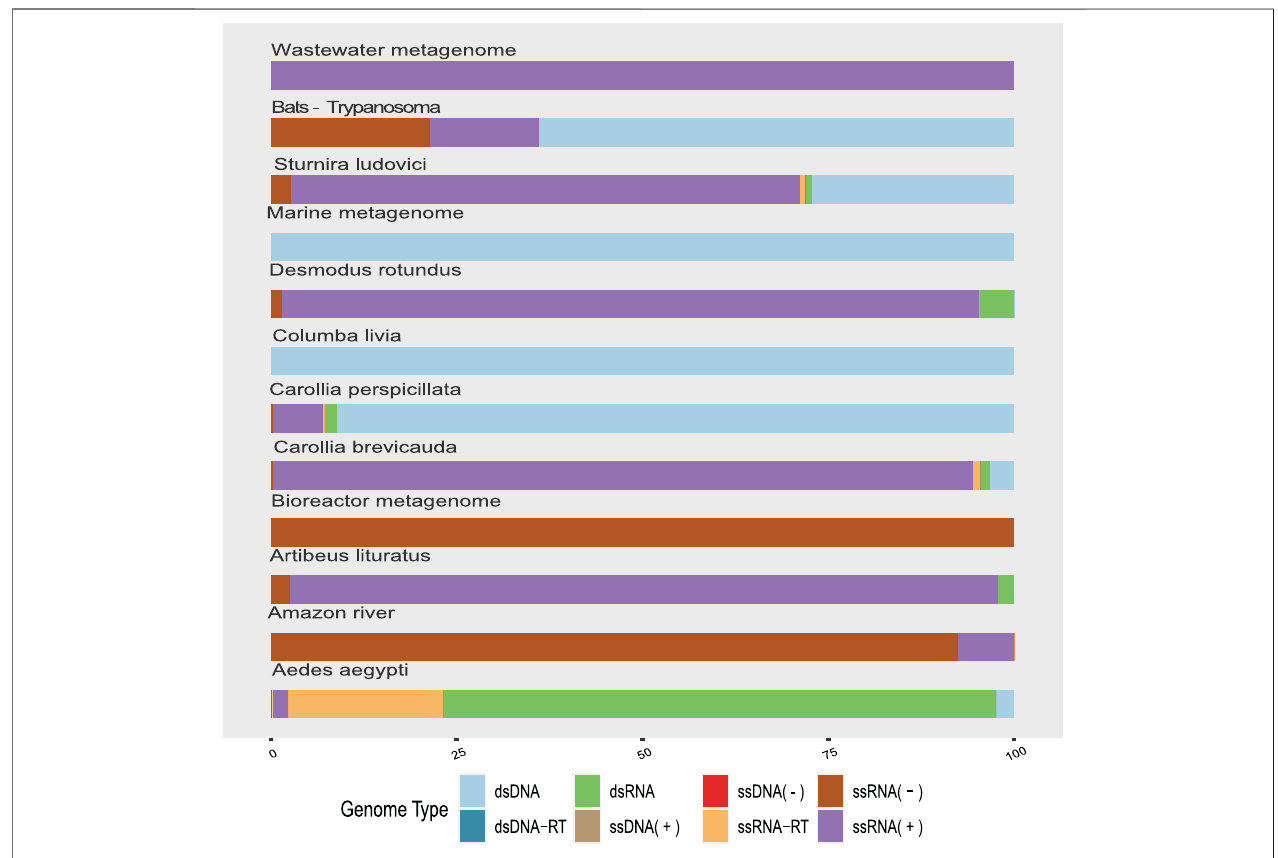
FIGURE2| Proportionofviralsequencesaccordingtotherelatedgenometypebysampleorigin.Thecolorsallowtoidentifyinthehorizontalbarstheproportionof sequences clustered according to their genome type ( y -axis) by sample origin ( x -axis).